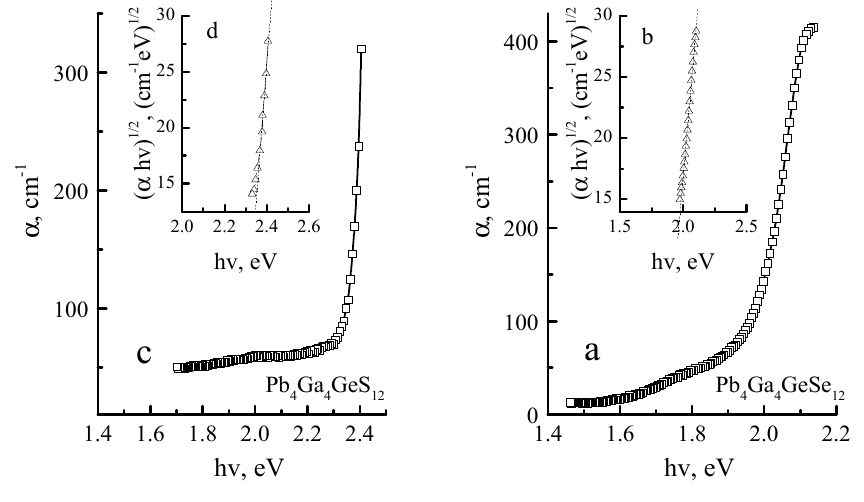
Figure 3. Typical absorption spectra ( a , c ) versus photon energy and extrapolated ( b , d ) spectra for the Pb 4 Ga 4 GeS 12 and Pb 4 Ga 4 GeSe 12